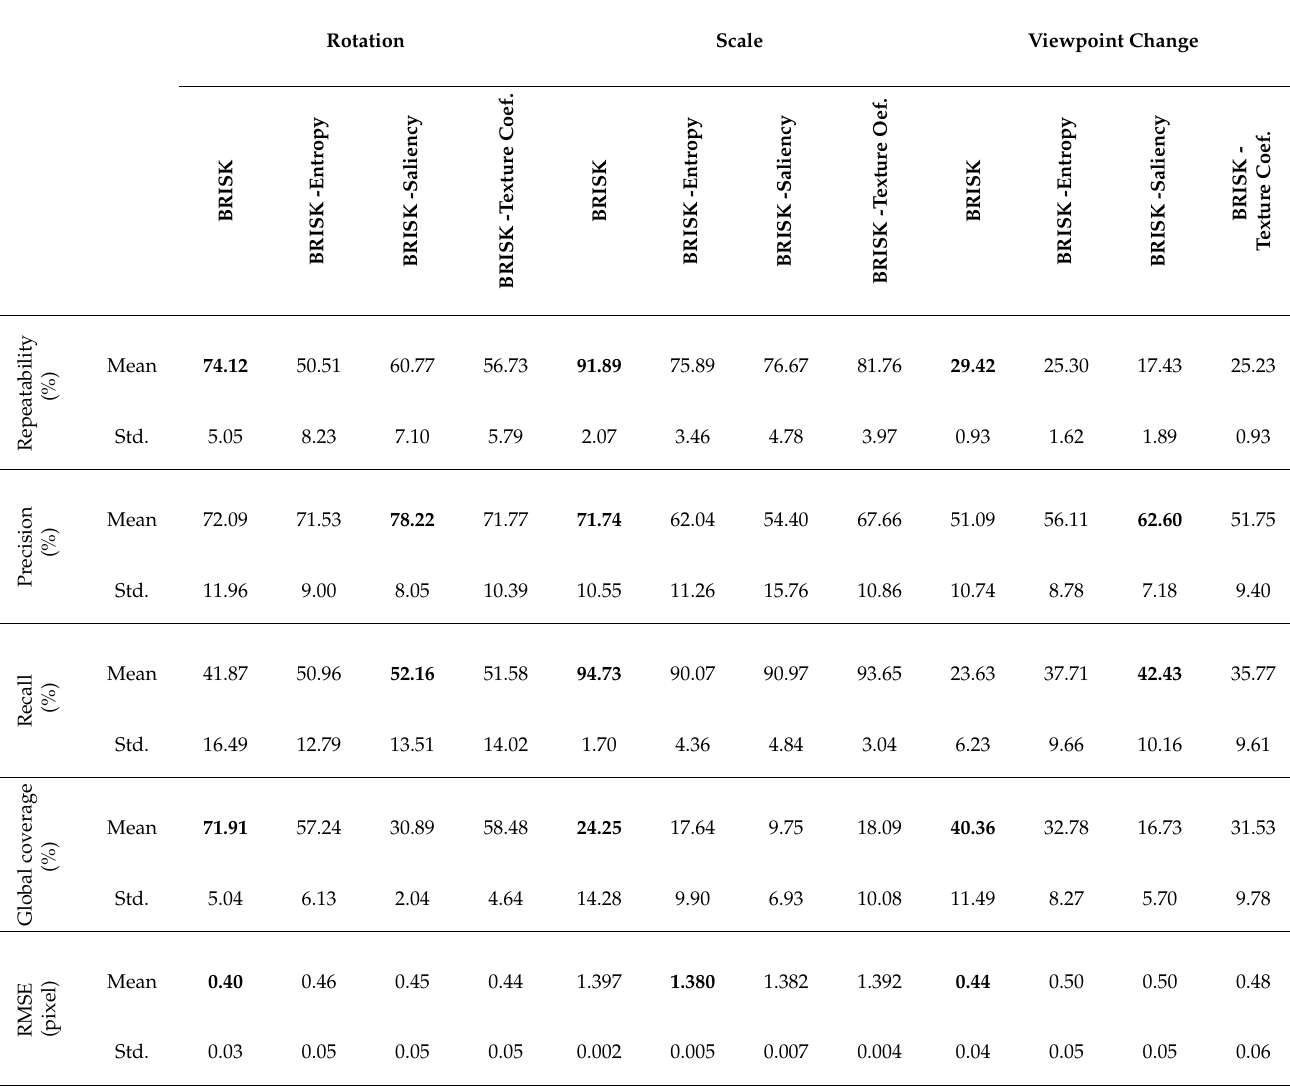
Table 5. The matching results of BRISK detector in synthetic images. Rotation Scale Viewpoint